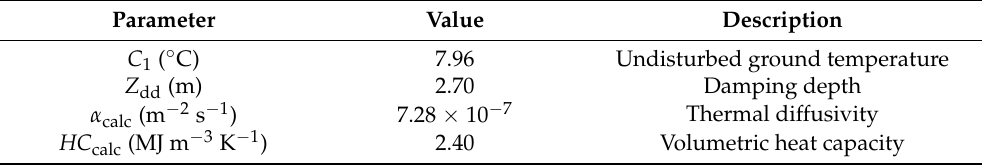
Table 2. In situ TD and HC estimated (Equations (2)–(6)) by applying the new heat tracing method on the temperature profile measured in 2015 at the INRS experimental site before a TRT.